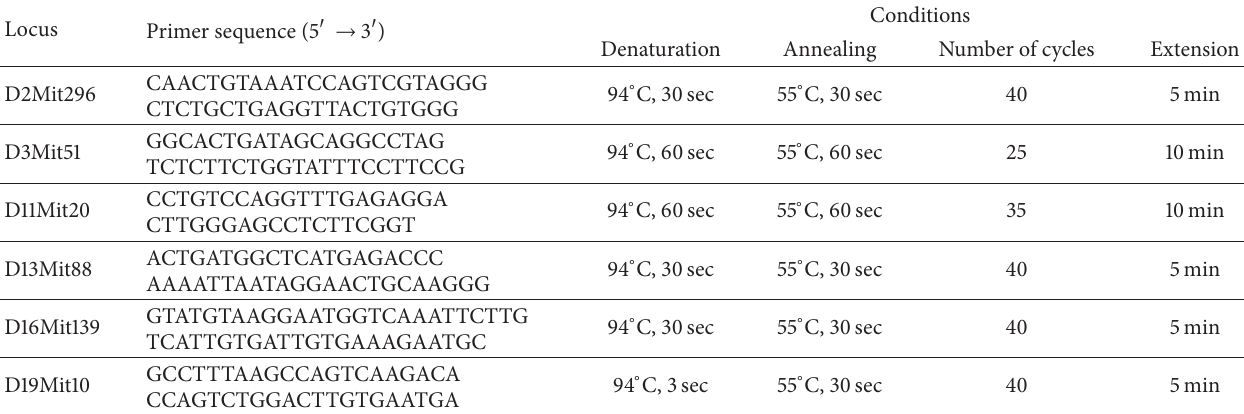
Table 1: Sequences of primers specific for microsatellite markers.